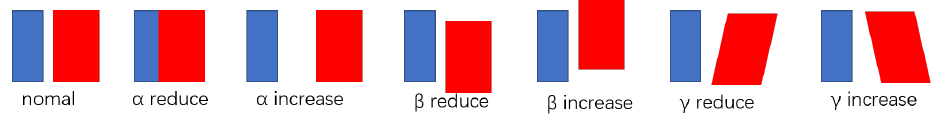
Figure 11. The impact of the double image offset (blue square and red square both represent one